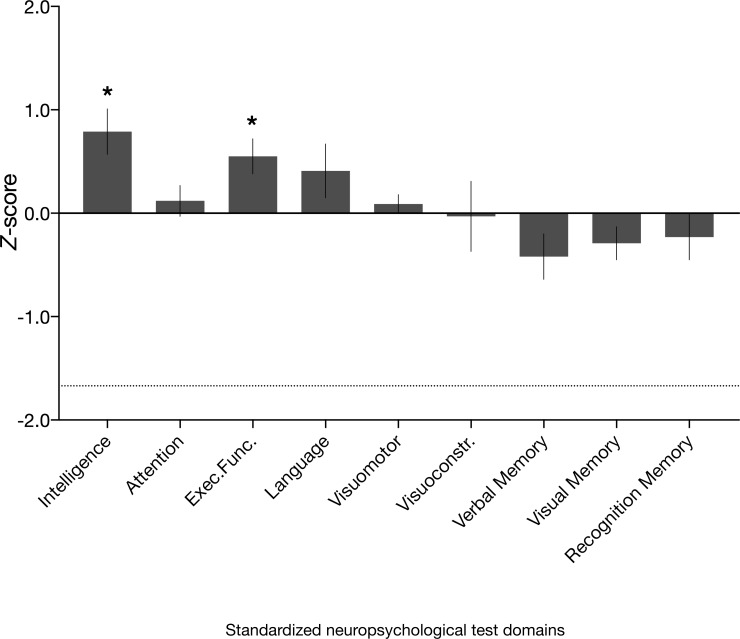
Neuropsychological domain performance in the amnesic group.Comprehensive assessment using standardized neuropsychological tests revealed that the scores for the amnesic group were comparable or significantly above normative data on composite measures of intelligence, attention, executive function, language, visuomotor skills, visuoconstruction skills, verbal memory, visual memory, and recognition memory (see 'Materials and methods' for individual subtest tests underlying the domain scores; Supplementary file 1a contains detailed results and N for each domain). Delayed verbal recall performance (which contributed to the verbal memory domain) was significantly different from normative data (N = 16, average z-score = −0.77, s.e.m. = 0.24, t(15) = –3.16, p=0.006), but above the threshold that typically indicates severe impairment (−1.67). Delayed verbal recall was comprised of Logical Memory II, Logical Memory II themes and Word Lists II (Wechsler Memory Scale–third edition [WMS-III]) and Doors and People, People Recall Test. By contrast, delayed visual recall (comprised of Rey Delayed Recall) was intact (average z = −0.08, s.e.m. = 0.20, t(15) = 0.41, p=0.685). Visuomotor = visuomotor skils; Visuoconstr. = visuoconstruction skills. Error bars correspond to the s.e.m.